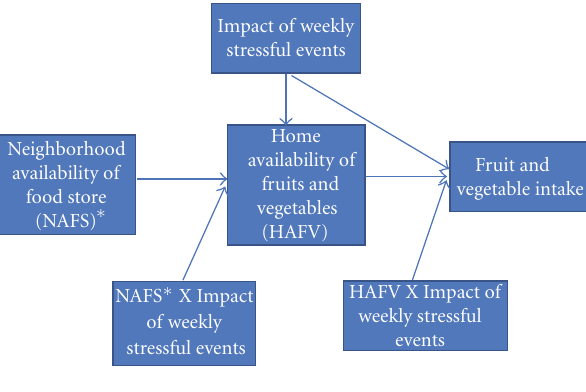
Figure 1: Conceptual model of the association between neighbor- hood availability of food stores and fruit and vegetable